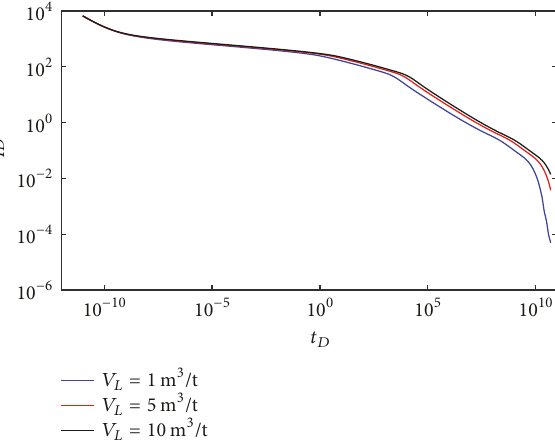
Figure 8: Effect of Langmuir volume ( 𝑉 𝐿 ) on